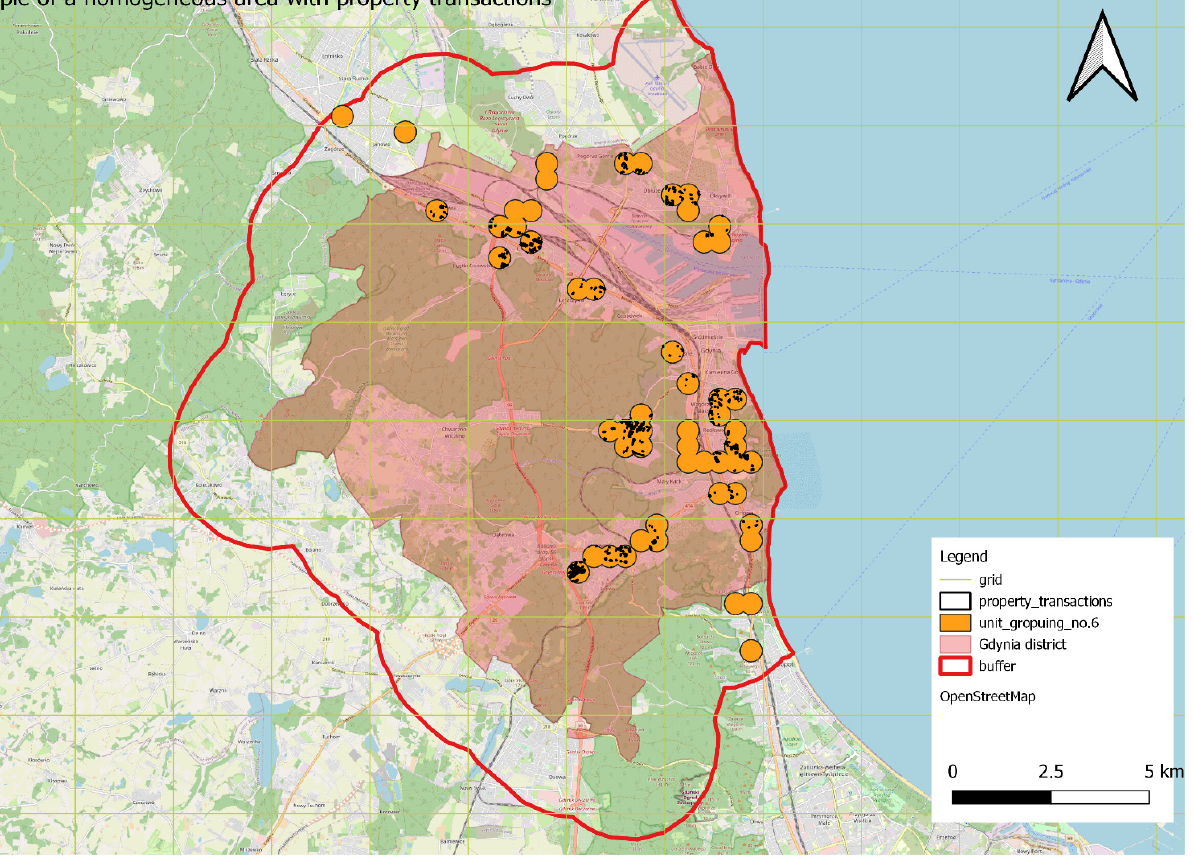
Table 3. Example of RST.Attr. groupings of homogeneous property attributes sets within a selected homogeneous area. Source: own elaboration.